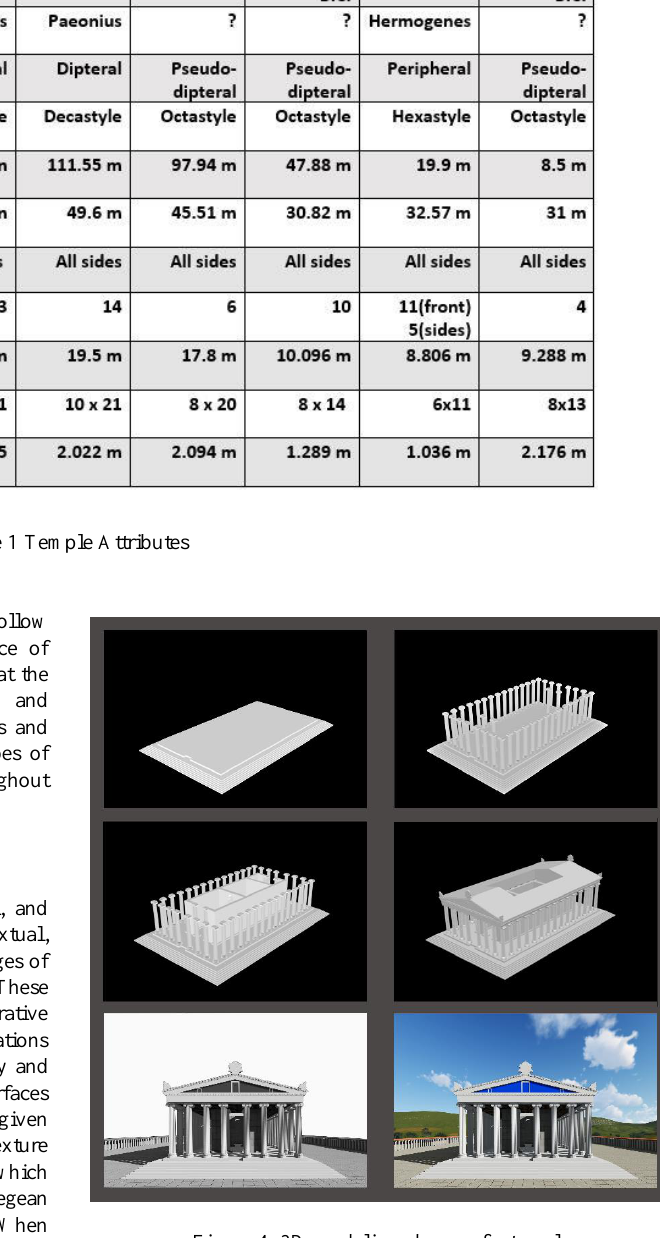
Figure 4. 3D modeling phases of a